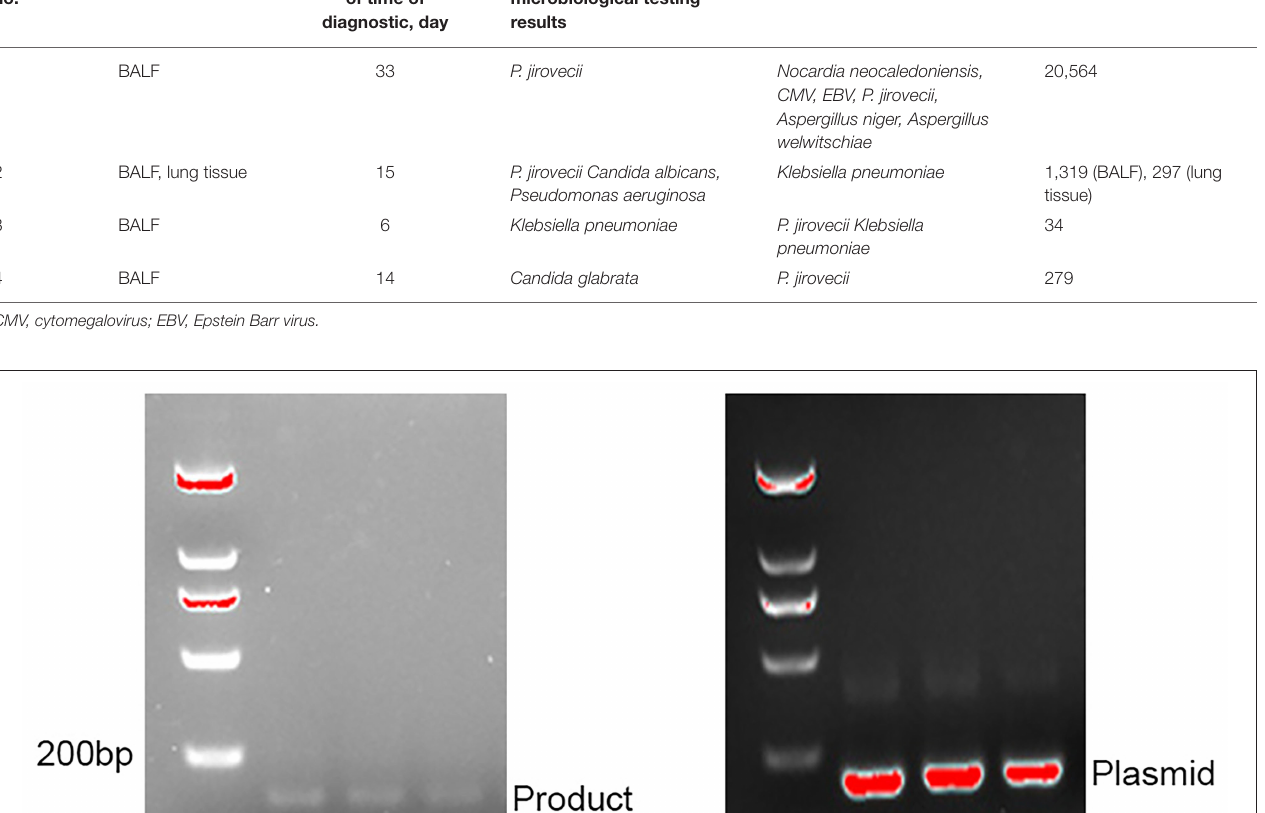
TABLE 2 | Summary of laboratory test results and metagenomic next-generation sequencing (mNGS) results. Patient no.